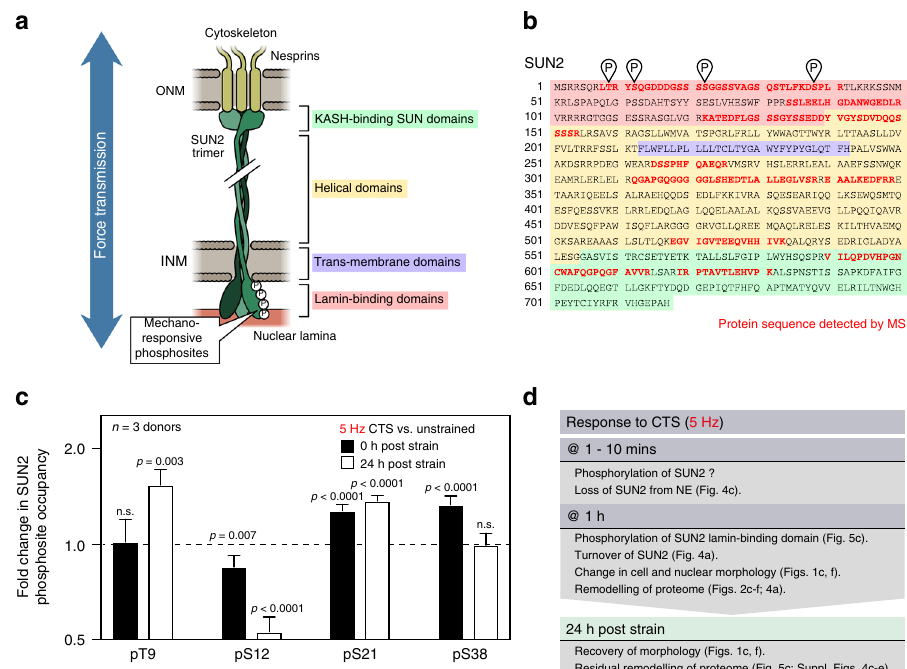
Fig. 5 The lamin-binding domain of SUN2 contains mechano-sensitive phosphorylation sites. a Schematic of SUN2 protein trimer spanning the NE and linking between the nuclear lamina and nesprins 71 . MS detected four mechano-responsive phosphorylation sites within the lamin-binding domain of SUN2. ONM = outer nuclear membrane; INM = inner nuclear membrane. b Amino acid sequence of SUN2 protein. Red indicates regions of the sequence detected by MS, showing coverage of domains across the length of the protein; phosphosites are also indicated. Domains are indicated according to the scheme shown in fi gure part ( a ). c Quanti fi cation of phosphorylation at sites in SUN2 (pThr9, pSer12, pSer21, pSer38) immediately, and 24 h following, CTS (1 h at 5 Hz, 2.6 – 6.2% strain; n = 3 donors). pS12, pS21 and pS38 showed an immediate response to strain ( p = 0.007, <0.0001, and <0.0001, respectively); changes to pT9, pS12, and pS21 suggested more persistent remodeling ( p = 0.003, <0.0001, and <0.0001, respectively). Data displayed as mean and s.e.m.; p -values were calculated using empirical Bayes-modi fi ed t -tests with Benjamini – Hochberg correction. d Summary of evidence that suggests a sequential mechanism for nuclear decoupling, and subsequent recovery, following high-intensity